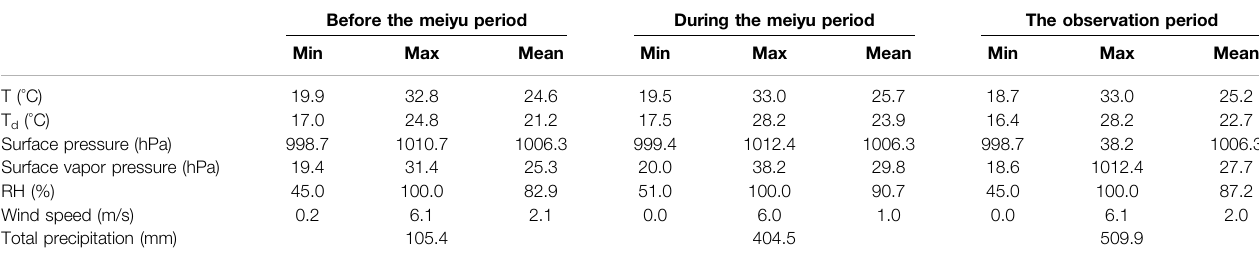
TABLE 1 | Statistic of meteorological conditions during sampling